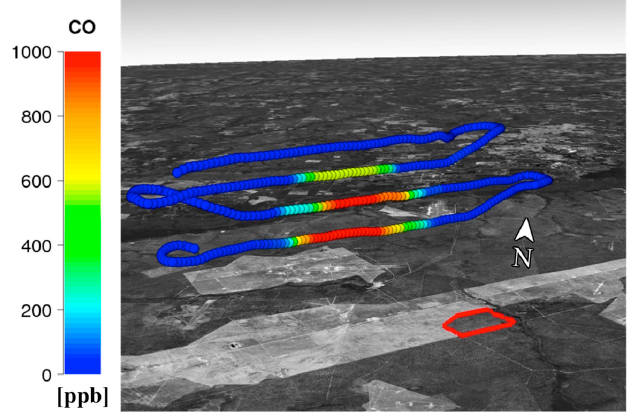
Figure 10. Observed CO enhancements during the parking garage #3 transect at 2035 UTC. Map data: Google, DigitalGlobe.